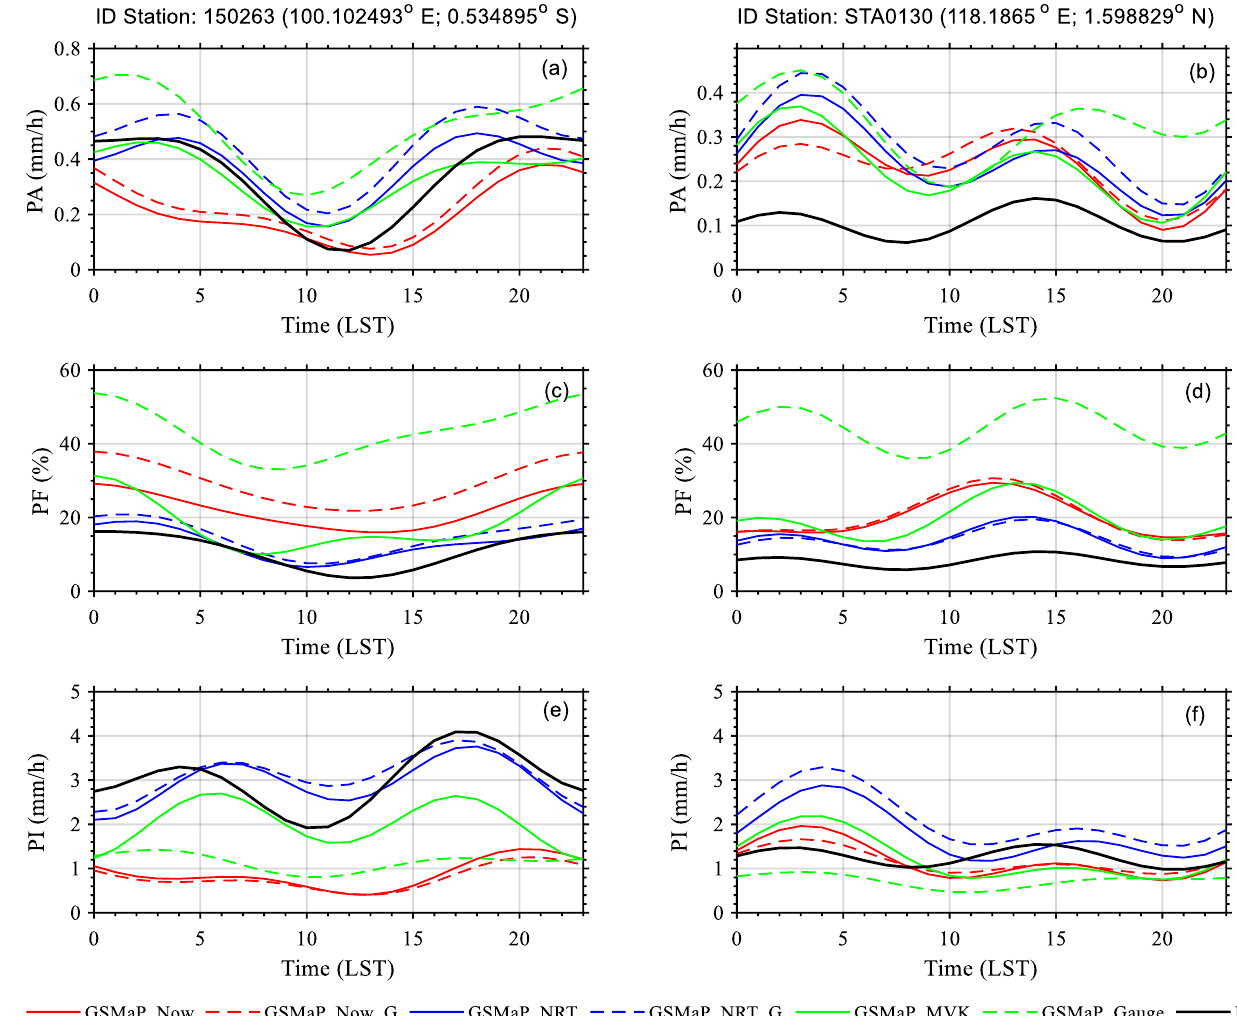
Figure 5. An example of the difference in the observed rainfall peaks from the GSMaP product and the rain gauge for PA ( a , b ), PF ( c , d ), and PI ( e , f ) with two rain peaks, at two observation stations. Overestimation of rainfall on GSMaP data causes higher PA and PI values than rain gauge. On the other hand, the FAR value of GSMaP hourly data, which is quite high, contributes to the difference in peak PF time between GSMaP and rain gauge. Thus, if the FAR is lowered, the PF peak time match between GSMaP and RG will be better. As the FAR value decreases and the POD increases with increasing timescale, using data with a longer time window (e.g., sub-daily) can also increase the compatibility of the peak time of the PF between the two instruments [67,80,85]. To more quantitatively illustrate the differences in peak times between PA, PF, and PI, we plotted the percentage of station numbers for differences of 0 h, 1 h, 2–3 h, and >3 h (Figure 6). Overall, the number of grids showing the suitability of the diurnal peak time observations is quite satisfactory, especially for PA and PF. The percentages of the number of grids showing the corresponding peak time values (difference 1–3 h) for PA, PF, and PI were 60–80%, 60–80%, and 38–50%. This trend of diurnal peak delay from SPP data was also found in previous studies